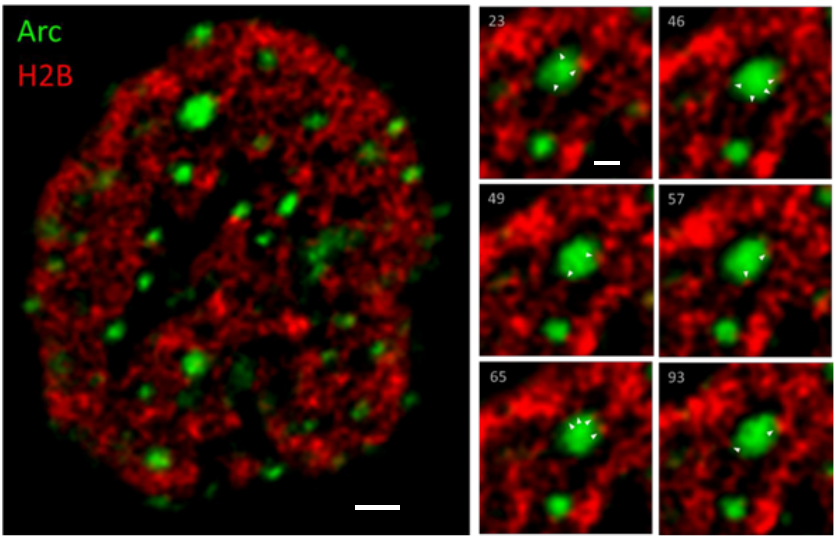
Figure 3. Arc associates with dynamic chromatin. Time-lapse movies of Arc-eYFP and H2B-mCherry expressed in hippocampal neurons (18 DIV) were obtained using a spinning disc confocal microscope (100×, 1.49 NA Apo TIRF objective). Z-stacks (5 images) were acquired for both YFP and mCherry channels. Three-dimensional blind deconvolution (AutoQuant) was used to remove out-of-focus fluorescence. The movie is 5 min long, 3.2 s between frames, which was the time required to acquire Z-stacks from both channels. The image on the left shows a single frame of the movie in the centre of the Z-stack of a neuronal nucleus (scale bar = 1 µm). Arc (green) is seen to form puncta, while H2B (red) labels the lattice-like chromatin structure. The panels on the right show six frames of a zoomed-in section illustrating small chromatin structures transiently interact with the two Arc puncta (scale bar = 500 nm). White arrowheads indicate points of contact between Arc and chromatin. The highly dynamic interaction of chromatin with Arc puncta is most clearly seen in the Movie S1 .